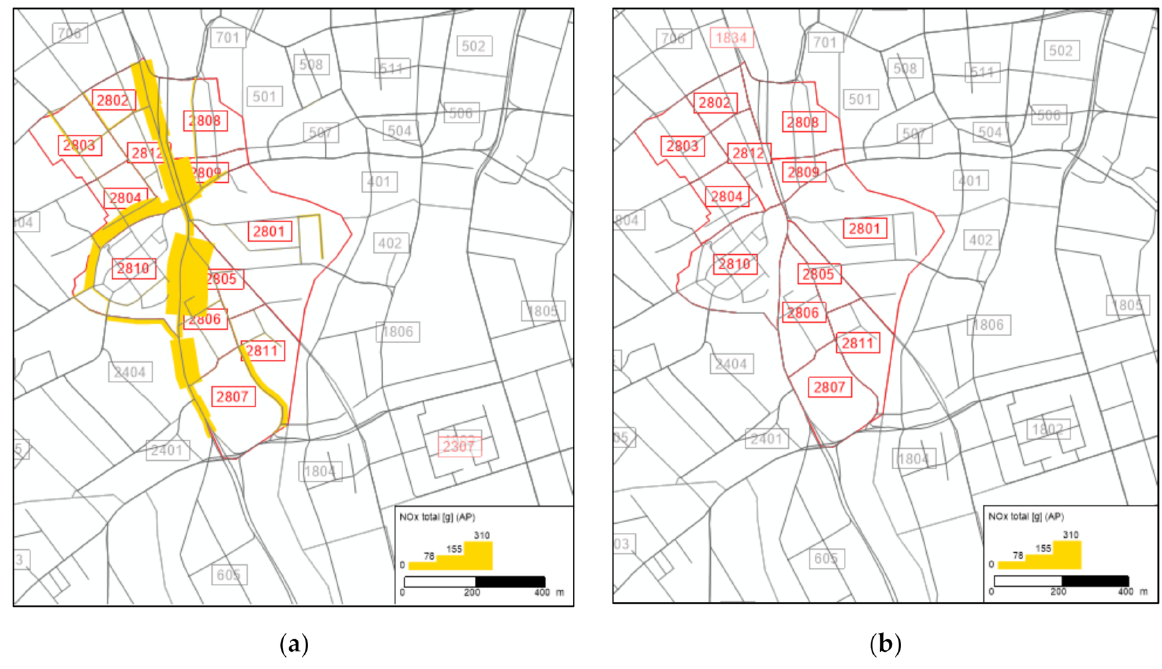
Figure 16. The assessment of NOx total [g] (measure from Group 1) for scenario W0 and optimal scenario (W3)—analysis for the central areas of the city: ( a ) measures for scenario W0; ( b ) measures for scenario W3.